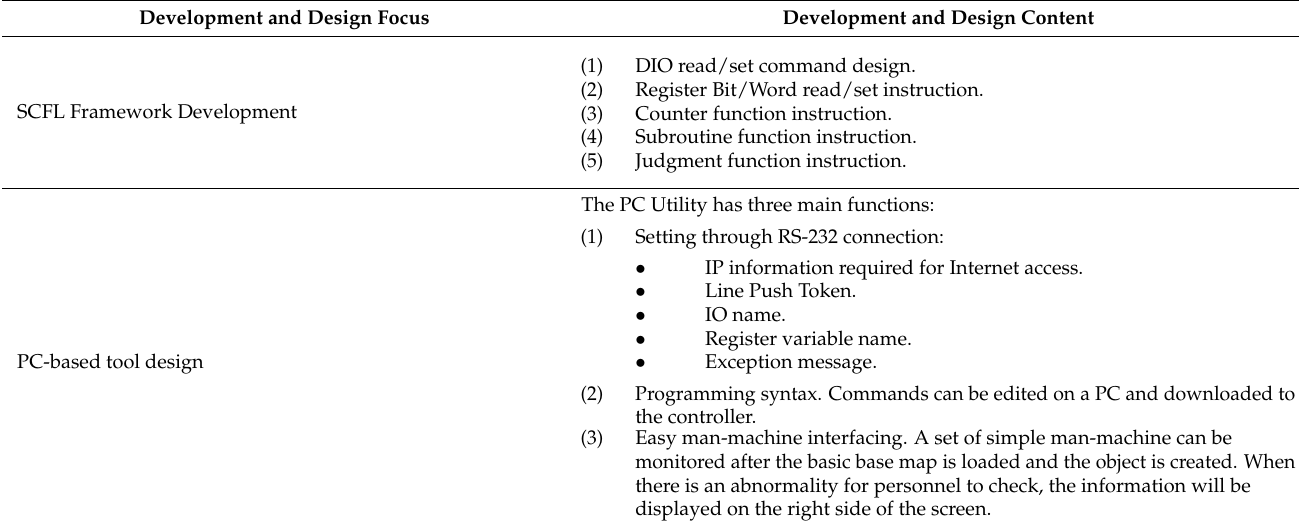
Table 2. Software Design Project Description.